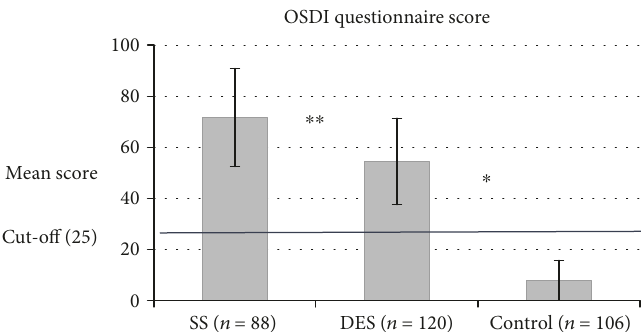
Figure 1: Severity of eye dryness by the OSDI questionnaire score. Cuto ff score = 25 . ∗ Comparison between the 3 groups with a one-way ANOVA test: P < 0 001 . ∗∗ SS vs. DES with an independent sample t -test: P < 0 001 . Error bars: standard